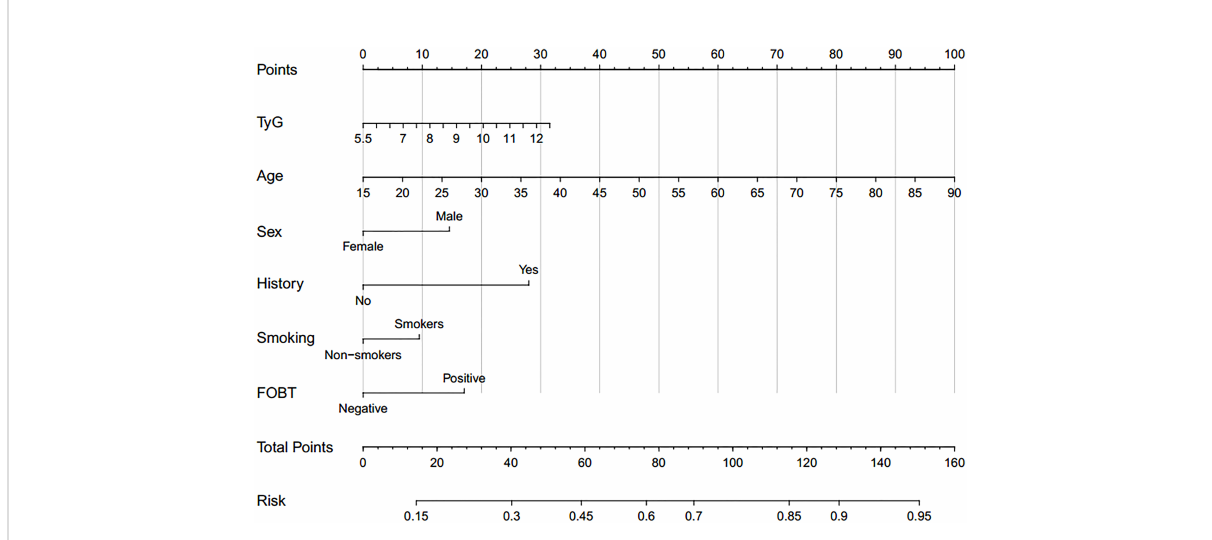
FIGURE 4 Nomogram for model 1 calculate individual neoplasm probability.